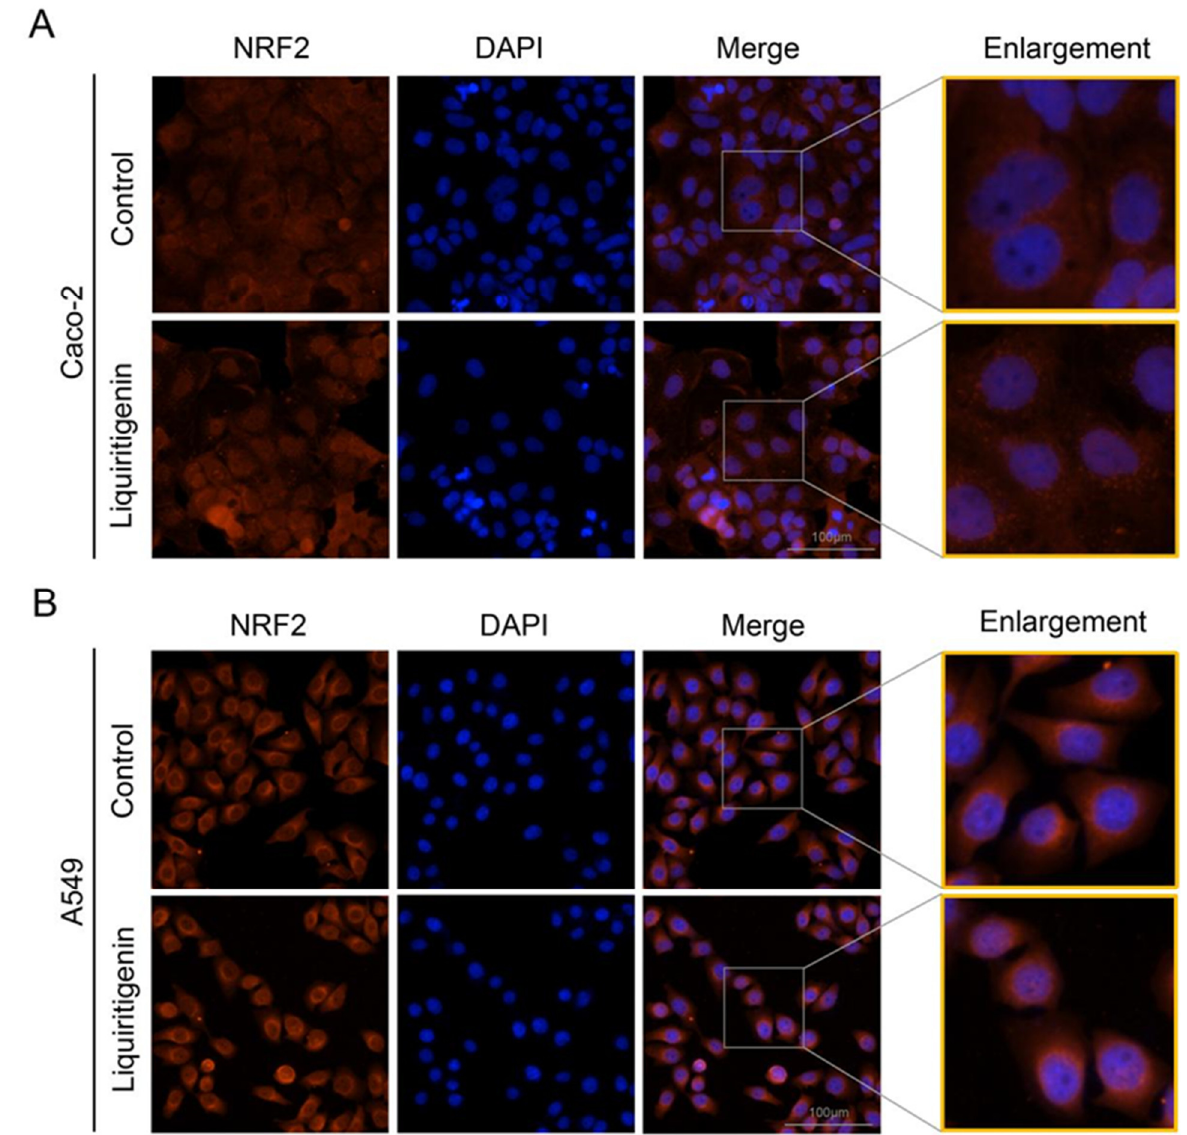
Figure 7. Subcellular location of NRF2 determined by immunofluorescence microscopy in Caco-2 ( A ) and A549 cells ( B ) with liquiritigenin treatment. Nuclei were revealed using 4′,6-diamidino-2-phenylindole staining.